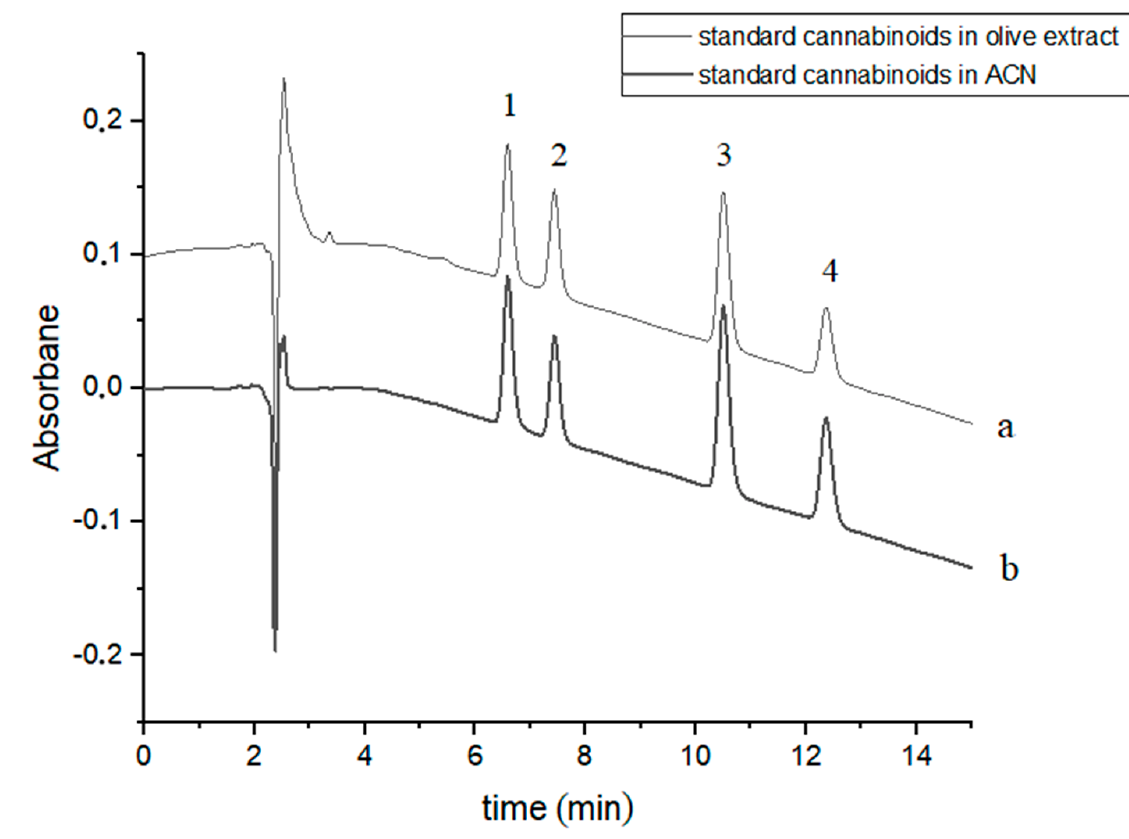
Figure 1. Chromatograms of four cannabinoids ‐ CBDA, CBD, CBN and Δ 9 ‐ THC—(a) in an olive extract and (b) in acetonitrile (ACN). The compounds were detected at λ = 220 nm. 1 —CBDA, 2— CBD, 3—CBN and 4— Δ 9 ‐ THC.